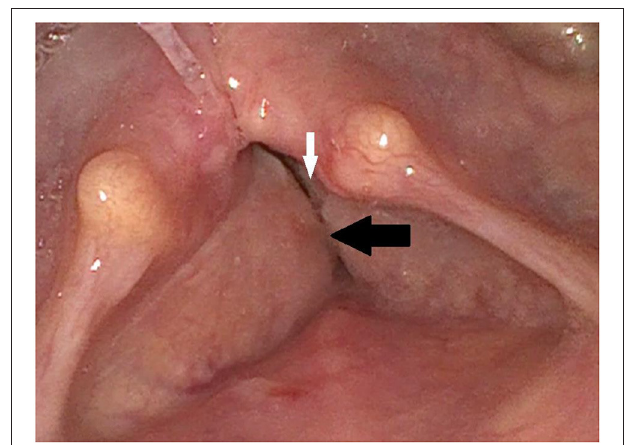
FIGURE 1 | Initial finding via laryngoscopy: The paralyzed vocal cords (white arrow) are partially covered by the hyperplastic vestibular folds (black arrow).